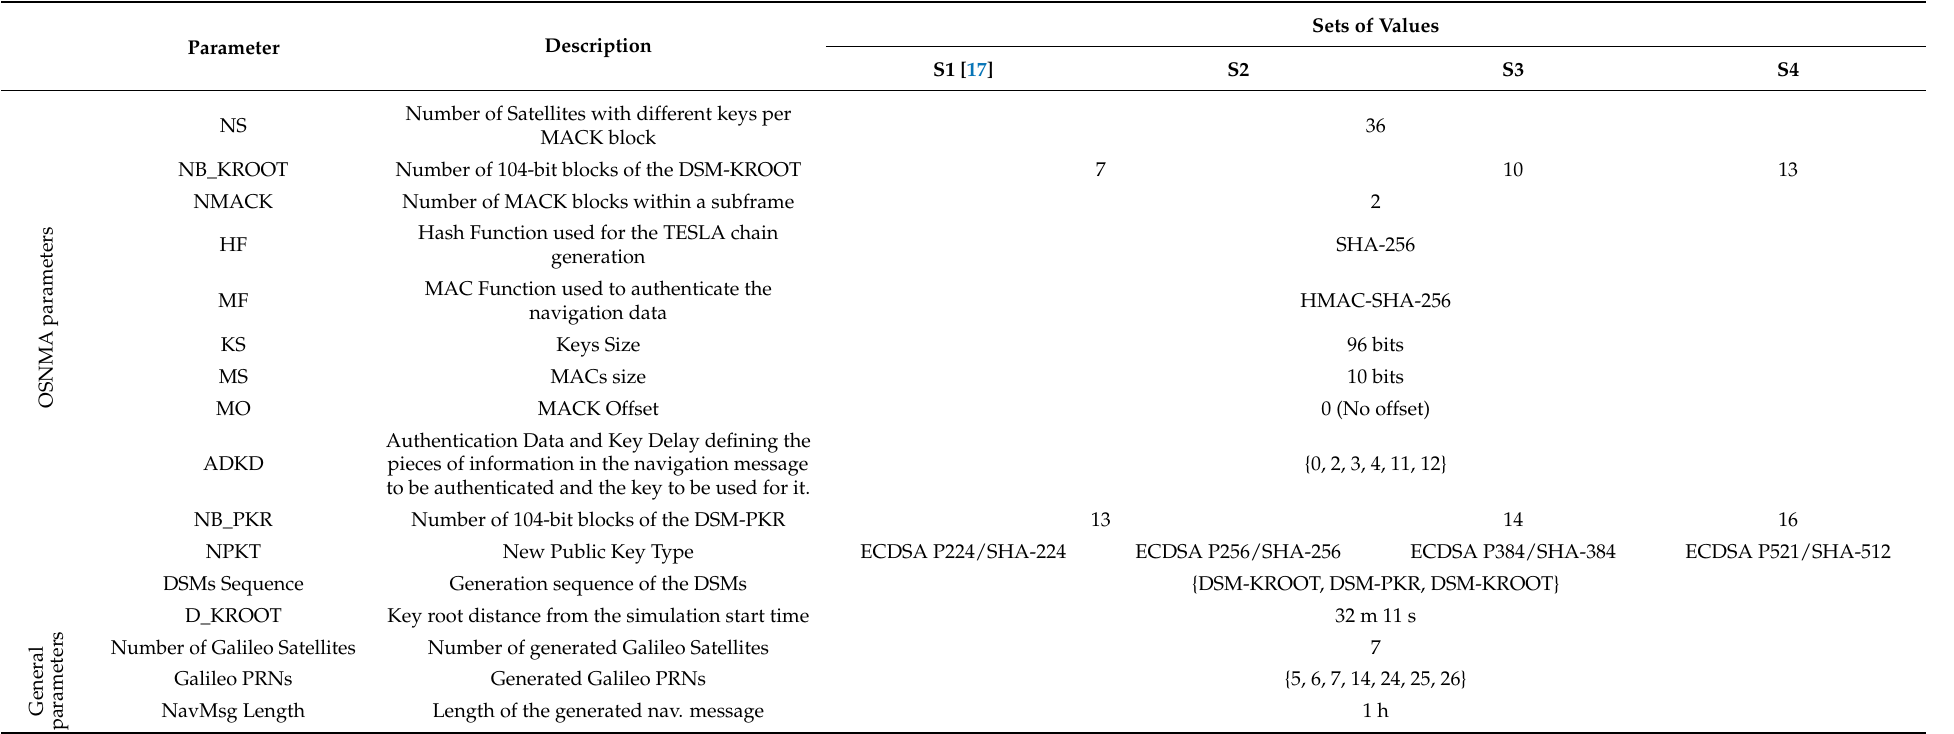
Table 3. Navigation message generation setup. © [2020] IEEE. Reprinted, with permission, from